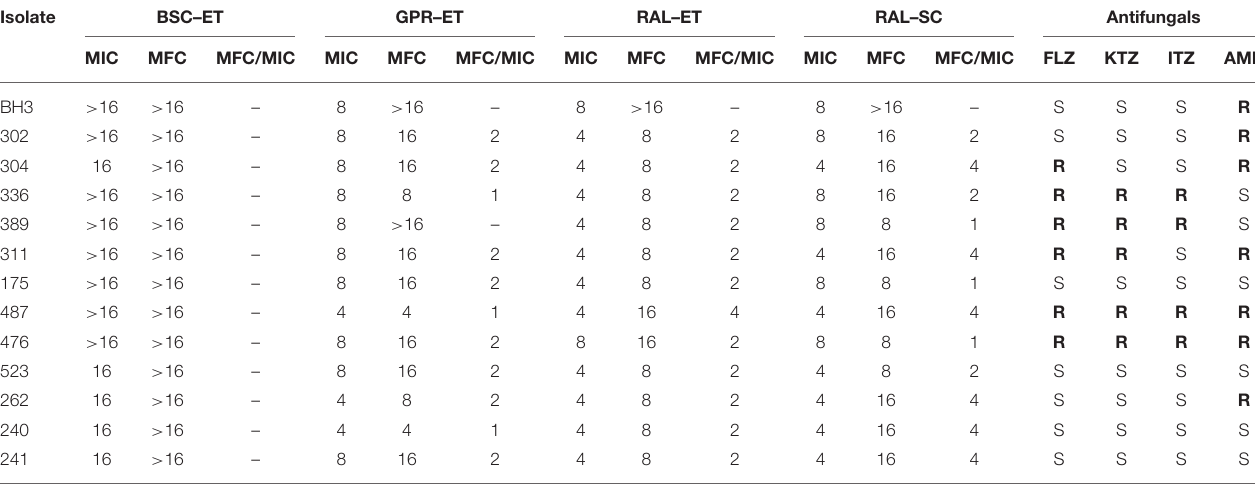
TABLE 2 | The MIC and MFC (mg/mL) values and MFC/CIM ratio for each type of propolis extract used against M. pachydermatis isolates, determined via broth microdilution.